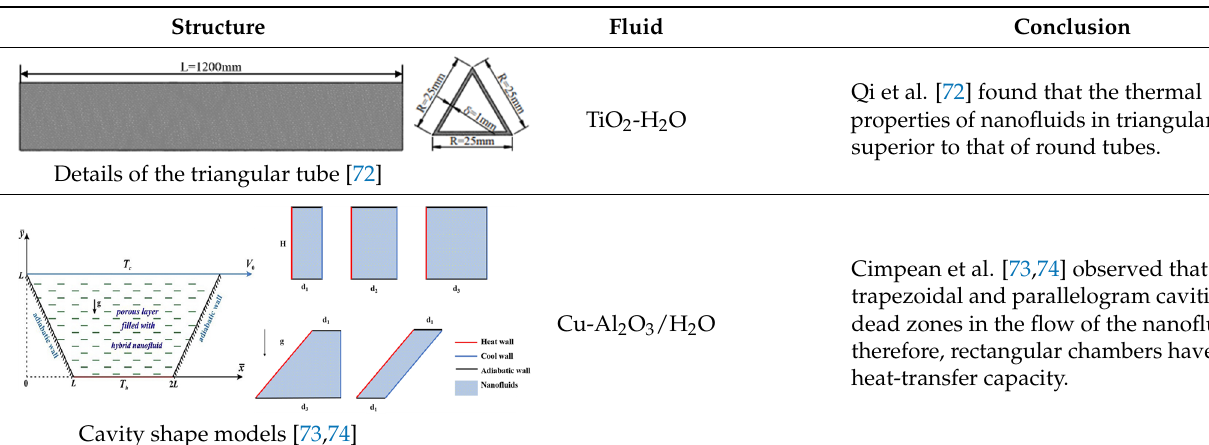
Table 2. Optimization of cavity shape and structure.